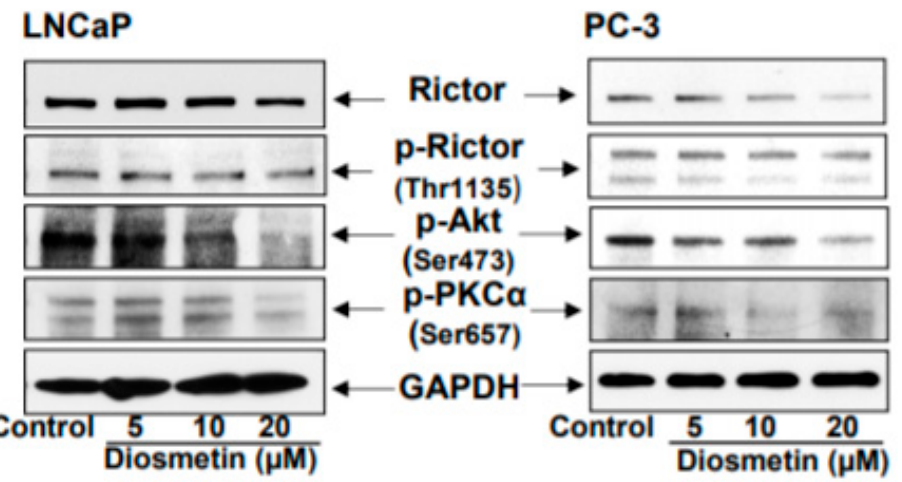
Figure 4. Diosmetin dose response treatment to prostate cancer cells inhibited Rictor, p-Rictor, p-AKT, and p-PKC α expression. LNCaP and PC-3 cells were treated with diosmetin in dose response (5, 10, and 20 µ M) for 24 h, and total lysates were made to observe the altered expressions of Rictor, p-Rictor (Thr1135), p-AKT (Ser-476), and p-PKC α Ser-657. For protein, control blots were stripped and reprobed with GAPDH.